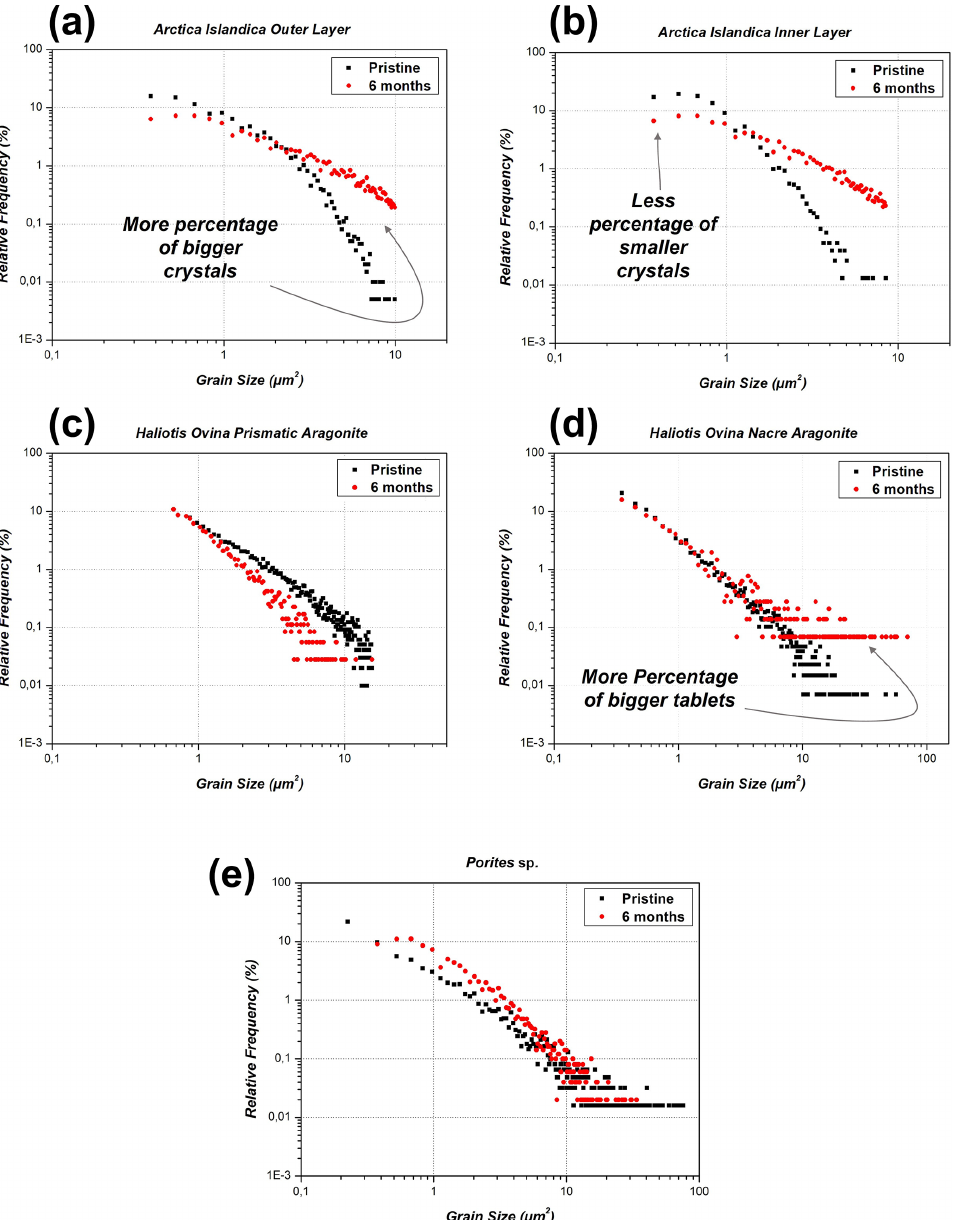
Figure 9. Relative frequency versus grain size/grain area for pristine and hydrothermally altered Arctica islandica , Haliotis ovina , and Porites sp. shells and skeletal elements. (a, b) In Arctica islandica shells, there is a dramatic redistribution of grain size, such that the amount of smaller grains decreases, while the amount of larger grains in the shell increases. This occurs in both the outer and the inner layer of the Arctica islandica shell. (c, d) In the shell of Haliotis ovina , the two layers follow a different evolution with progressive alteration. The grains in the prismatic layer decrease in size, while in the nacreous layer the amount of large grains increases. (e) For the coral Porites sp., we do not find significant variations in grain size/grain area with progressive